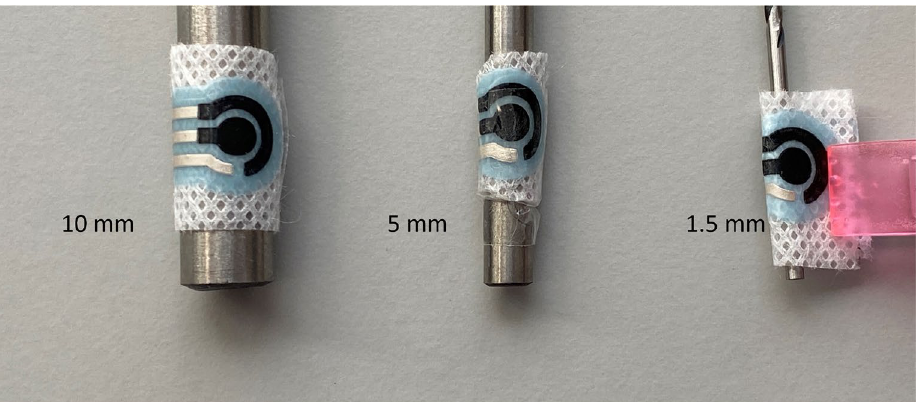
Figure 6. Flexibility test of printed sensors by wrapping around cylinders with a diameter ranging from 1 to 10 mm (only 10 mm, 5 mm and 1.5 mm are shown